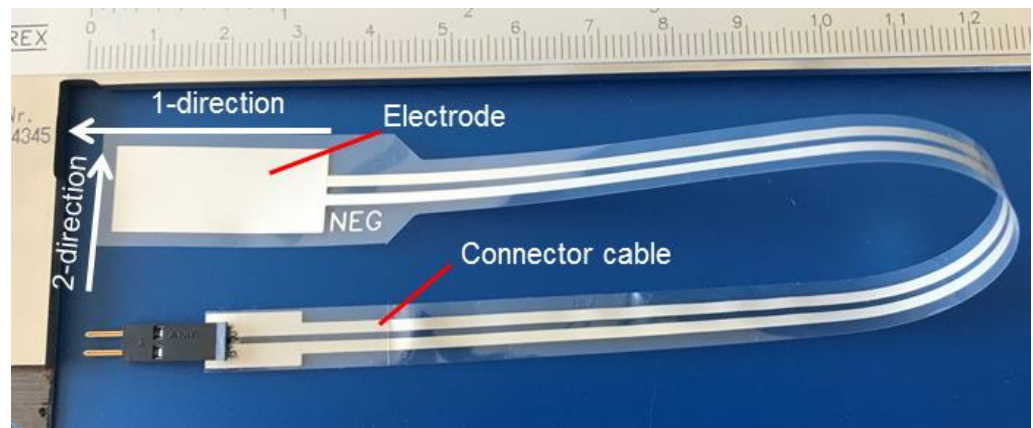
Figure 2. PVDF sensor foil. Table 1. Geometrical dimensions of PVDF sensor foils and